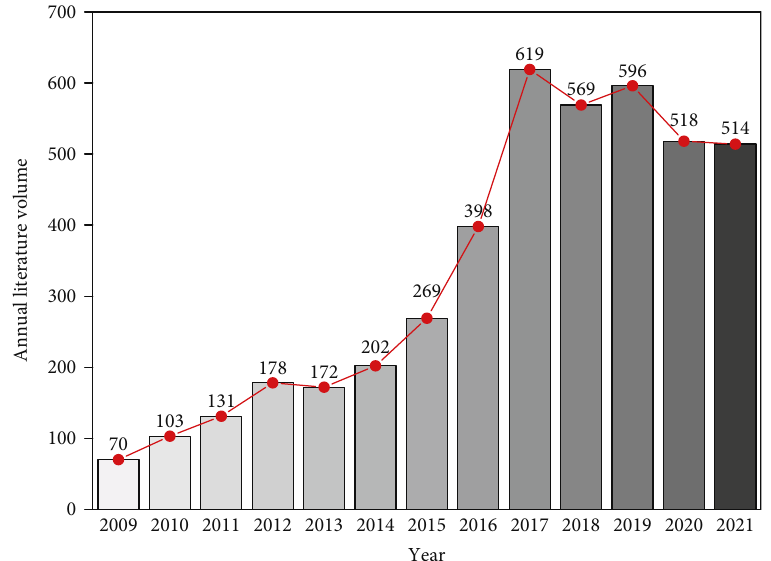
Figure 1: The annual literature volume about “ Innovation and entrepreneurship education ” at the web of science database from 2009 to 2021.